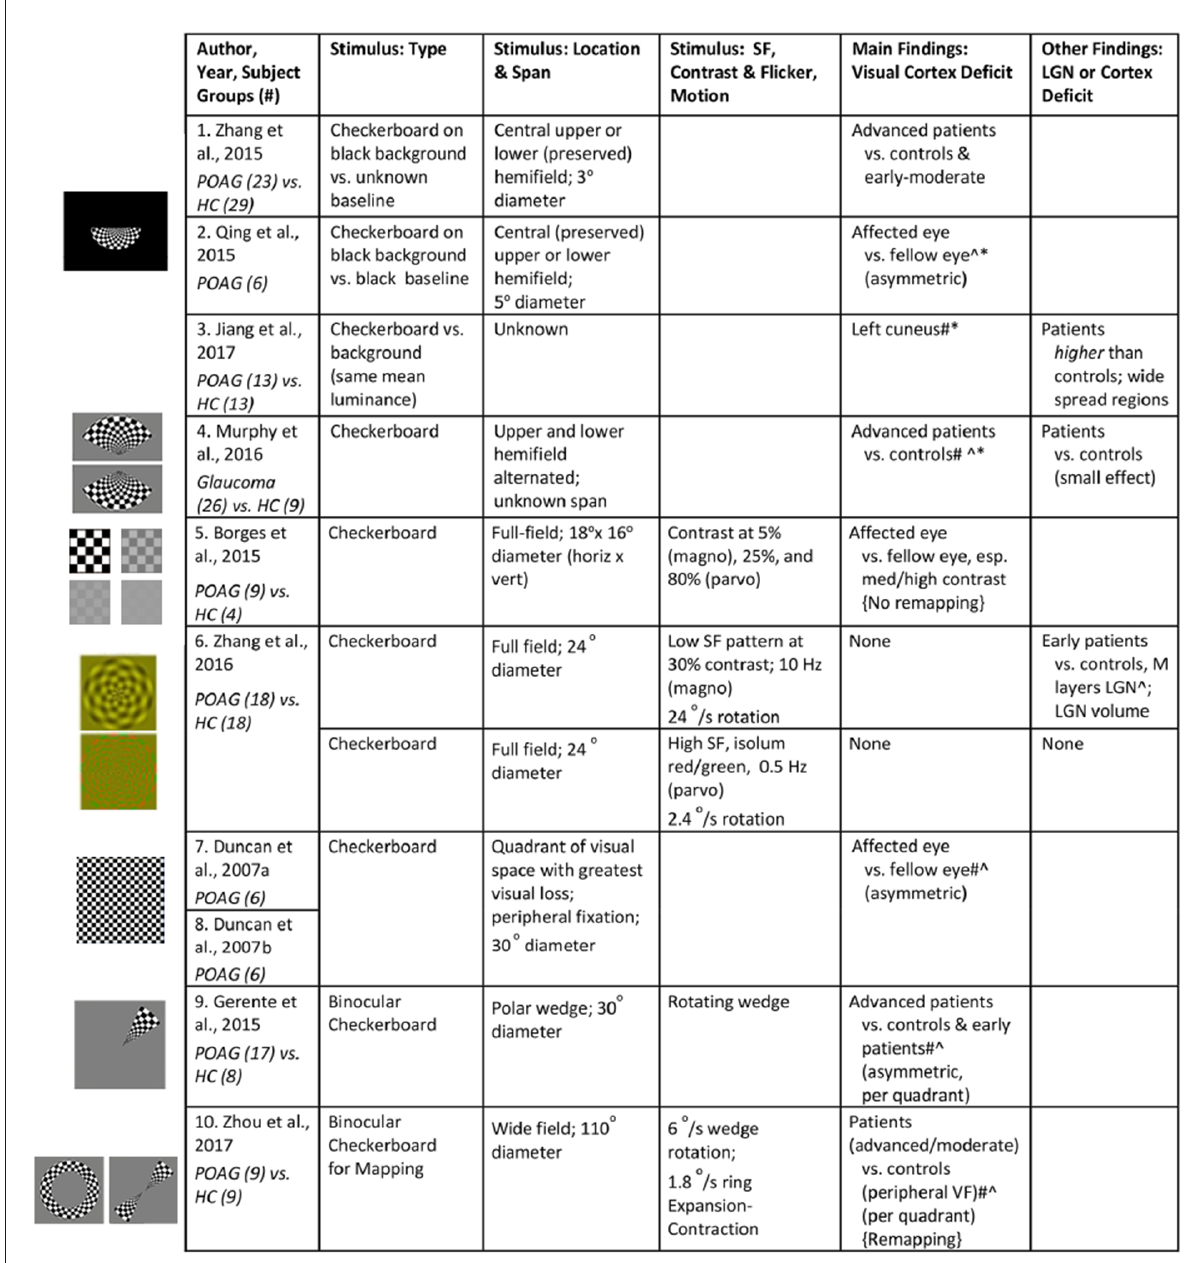
FIGURE3 Summary of visual stimuli utilized and findings in visually-driven fMRI studies of glaucoma. The studies are listed in increasing order of the size of the checkerboard stimulus utilized. Left: Images of visual stimuli, similar to the ones utilized in each of the studies, have been provided. Note: Images in row 1, 2, 4, 9, and 10 are created with a figure licensed under a Creative Commons Attribution 4.0 International (https://creativecommons.org/licenses/by/4.0/, https://creativecommons.org/licenses/by/4.0/legalcode). It is attributed to Biological Psychiatry (https://www.sciencedirect.com/science/article/pii/S0006322307012413?via%3Dihub#fig1). Cropped in various shapes from original. Images in row 6 is obtained from Zhang et al. (2016) © 2015 Wiley Periodicals, Inc. ∧ Deficit indicated by correlation with visual sensitivity measures (i.e., BOLD activity declines with increasing severity measure). ∗ Compensation indicated by correlation with visual sensitivity measures (i.e., BOLD activity increases with increasing severity measure). # Deficit indicated by correlation with retinal thickness (i.e., BOLD activity declines with increasing severity measure). # ∗ Compensation indicated by correlation with retinal thickness (i.e., BOLD activity increases with increasing severity measure). SF, spatial frequency; VF, visual field; POAG, primary open-angle glaucoma; HC, healthy controls.